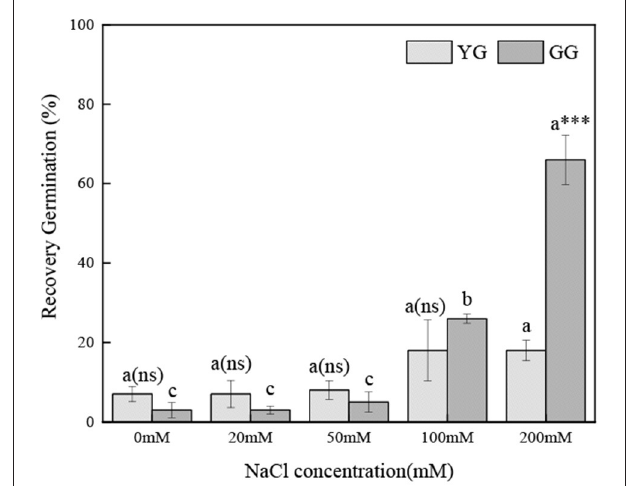
FIGURE 1 | Effects of salt stress on the seed germination of different L. chinensis ecotypes incubated at 28/16 ◦ C (12 h light/12 h dark) for 30 d. There were four replicates for each treatment. Values are means ± standard error (SE); Different lowercase letters indicate significant differences between the different NaCl concentrations under the same ecotype. *, **, ***Indicate significant differences between the different ecotypes under the same NaCl concentration at 0.05, 0.01, and 0.001 level respectively, and “ns” indicates no significant differences.